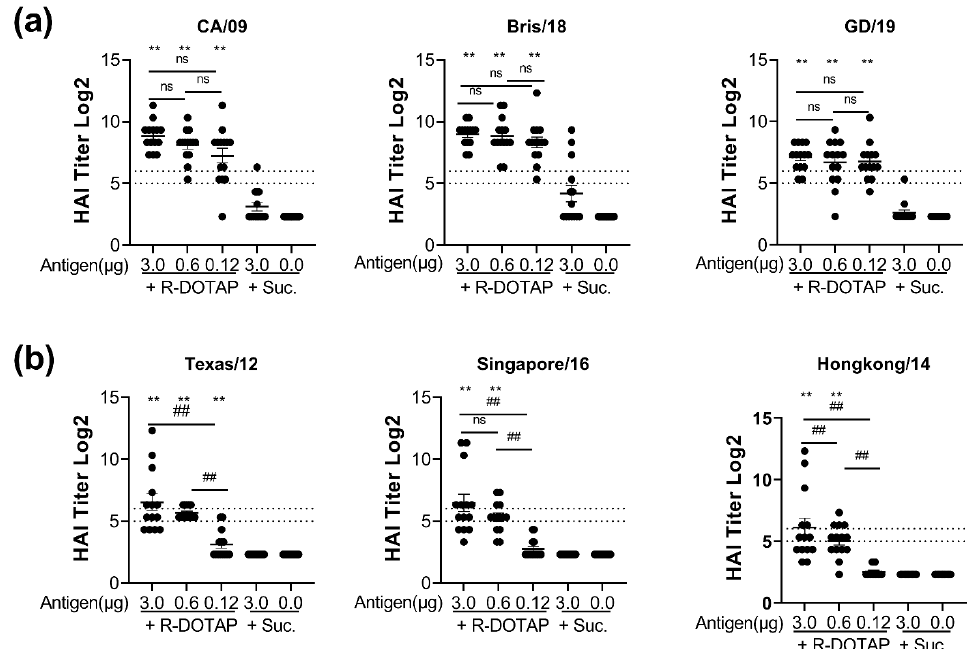
Figure 4. Bivalent COBRA antigens formulated with R-DOTAP induced robust neutralizing and broadly cross-reactive antibodies against H1N1 and H3N2 viruses. Groups of DBA/2J ( n = 14) mice were immunized on day 0 and day 28 with two intramuscular doses of bivalent vaccines containing the indicated concentrations of COBRA-NG2 (H3), and COBRA-Y2 (H1) proteins formulated with R-DOTAP nanoparticles or sucrose buffer (no adj). Serum samples obtained from vaccinated mice 14 days after the second dose were assessed for functional antibodies by measuring HAI titers against H1N1 ( a ) viruses (A/California/09 (CA/09), A/Brisbane/18 (Bris/18), and Guangdong/19 (GD19)) or H3N2 ( b ) viruses (A/Texas/12, A/Singapore/16, Hongkong/14) viruses. Dotted lines represent HAI titers between 1:32 and1:64. Data represent mean ± SEM of HAI titers from each mouse. Comparisons between groups was performed using Kruskal–Wallis test in GraphPad Prism (9.0). ** p ≤ 0.05, significantly different between antigen+ sucrose and antigen + R-DOTAP. ## p ≤ 0.05 between groups compared. ns; not significant ( p ≥ 0.05). Experiment was repeated in BALB/cJ mice with similar results.